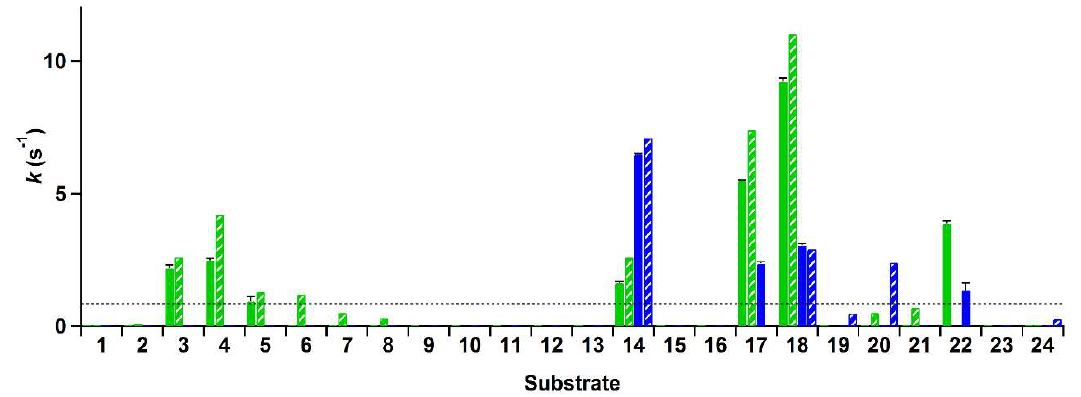
Figure 2. Rate of the reactions of His-tagged vanillyl alcohol oxidase (His-VAO) and His-tagged eugenol oxidase (EUGO-His) with the compounds used in the substrate specificity screening in 50 mM potassium phosphate buffer, pH 7.5, at room temperature (19–20 ◦ C) as determined using the xylenol orange assay. Solid bars give the reaction rates measured with the xylenol orange assay for His-VAO (green) and EUGO-His (blue). Error bars represent the standard deviation of duplicate measurements. Striped bars give k cat values measured previously by other methods with the non-His-tagged enzymes. These k cat values were measured under identical experimental conditions, with the exception of the temperature, which was 25 ◦ C instead of 19–20 ◦ C. The striped horizontal line indicates the detection limit of the xylenol orange assay, which corresponds to a reaction rate of 0.83 s − 1 . The k cat values were from the following sources. VAO: compounds 1 , 4 [33], 5 – 8 , 20 , 21 [11], 2 , 24 [14], 3 , 14 , 18 [13], 17 [34]. EUGO: 20 , 24 [4], 19 [9], 14 , 18 [13]. Numbering is according to Table 3.